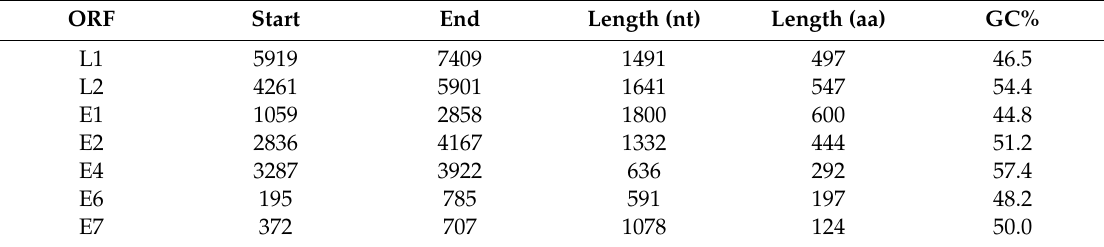
Table 2. ORF characteristics of Felis catus Papillomavirus 6